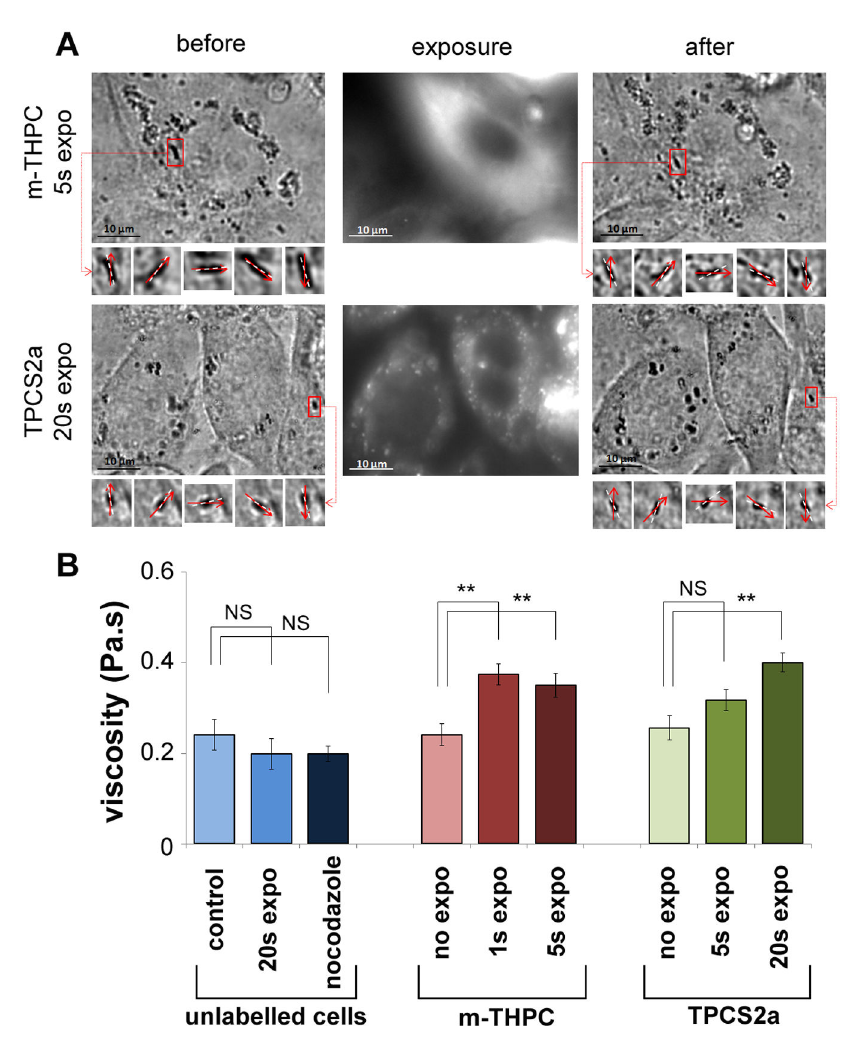
Figure 5. Measuring intracellular viscosity. (A) Example of rotations of a chain of magnetic endosomes before and after exposure, for the mTHPC (top) or the TPCS2a (bottom) photosensitizers. The phase lag φ between the direction of the magnetic field (dotted white line) and the direction of the selected chain (red arrow) are indicated in each case. For these two examples, the viscosity around the observed chain slightly increased after treatment, from 0.11±0.01 Pa.s to0.18±0.03 Pa.s Pa.s in the mTHPC case, and from 0.25±0.05 Pa.s to 0.55±0.04 Pa.s in the TPCS2a case. (B) Mean viscosity (averaged over 25 independent measurements at least) is shown for each condition (for unlabeled control cells, for unlabeled cells exposed for 20s, for unlabeled cells treated with nocodazole (10µM, 30min), for cells treated with m-THPC (without exposition, or exposed for 1s and 5s), for cells treated with TPCS2a (without exposition, or exposed for 1s, 5s, and 20s). Controls and cells treated with photosensitizers but not exposed all display the same viscosity mean value, in order 0.25 Pa.s. After nocodazole treatment, the mean viscosity value slightly decreases to 0.2 Pa.s but not significantly, while after exposure of the photosensitizers, it increases to 0.4 Pa.s at maximum. This increase is significant considering a confidence level of p<0.01. The error bars represent the standard error of the mean (SEM), NS (Non Significant) corresponds to p > 0.05, and ** corresponds to p<0.01.